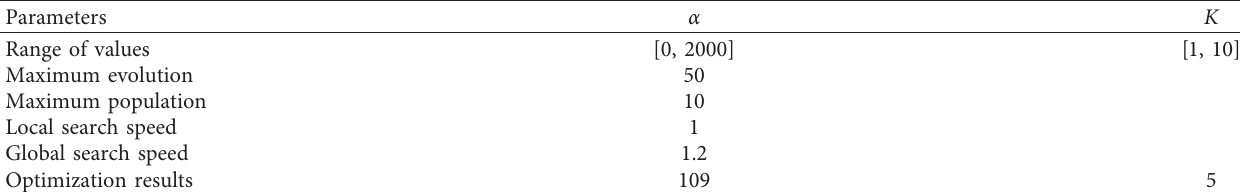
Figure 24: The trend of local energy ratio with evolution algebra. Table 7: Parameters setting and optimization results of